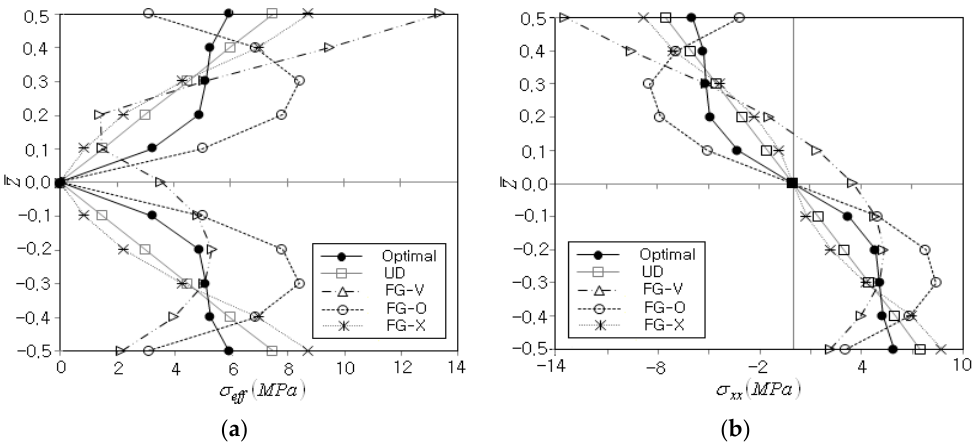
= * = 0.12): ( a ) the effective stress, ): ( a ) the effective stress, cnt cnt